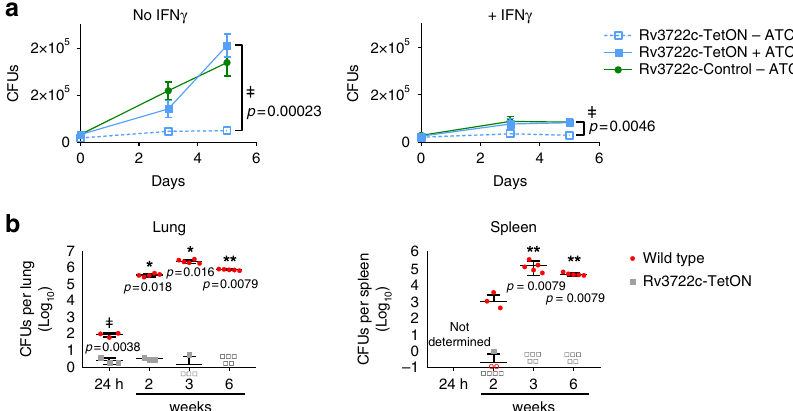
Fig. 2 Rv3722c is required for virulence in macrophages and mice. a Timecourse of macrophage infection. Primary murine bone marrow-derived macrophages were treated with control or interferon γ (IFN γ ) for activation, followed by infection with Rv3722c-control and Rv3722c-TetON precultured in 7H9 + casein hydrolysate with or without ATC to predeplete Rv3722c (multiplicity of infection of one). The number of colony-forming units (CFUs) was assessed by plating serial dilutions on 7H10 solid media supplemented with casein hydrolysate and ATC. Data are presented as mean + / − SD of three experimental replicates ( n = 3) representative of two independent experiments. b Timecourse of mouse infection. Mice were infected with aerosolized wild-type Mtb and Rv3722c-TetON precultured in Sauton ’ s without ATC to generate Rv3722c-de fi cient Mtb . After infection, mice were fed chow without doxycycline. The numbers of CFUs in lung and spleen were assessed by plating serial dilutions on 7H10 solid media with and without ATC to determine the number of non-ATC-dependent mutants. No non-ATC-dependent Rv3722c-TetON mutants were detected at any timepoint. Data are represented as mean + / − SD of fi ve mice ( n = 5), except for the 24 h timepoints ( n = 3) and Rv3722c-TetON 3 weeks in the lung ( n = 4). Open symbols indicate samples in which the bacterial burden was below the limit of detection (<2 CFUs). A similar experiment is shown in Supplementary Fig. 2. Source data are provided as a Source Data fi le. Statistically signi fi cant differences were identi fi ed in panel a by a combination of a two-sided unpaired Students t test ( p < 0.05, as indicated) and Mann – Whitney U rank testing (for which the smallest possible p -value with n = 3 is 0.1) (double dagger); and in panel b by an unpaired, two-sided Mann – Whitney U rank testing ( *p < 0.05, **p < 0.01, as indicated), except for the 24 h timepoint, in which statistically signi fi cant differences were determined as in a Rv3722c functions as an aspartate aminotransferase . To de fi ne studies identi fi ed Asp as the preferred substrate and Kyn as a the substrate speci fi city of Rv3722c, we next incubated Rv3722c weaker alternative (Fig. 3d), with af fi nities towards Asp that were with a panel of 26 amino acids, using α KG, pyruvate, and oxa- similar to AspATs from other species 21,22 . His, Cys, Asn, and Gln exhibited extremely low rates of turnover consistent with kinetic loacetate as potential amino acceptors. Oxaloacetate and α KG, side reactivity (Supplementary Fig. 4C). These results thus but not pyruvate, served as amino acceptors, while kynurenine annotate Rv3722c as an aspartate aminotransferase (AspAT; (Kyn), Asp, and Glu served as the best amino donors (Supple- Fig. 3e), with a weak, but signi fi cant, side activity toward Kyn, as mentary Fig. 4A). In contrast, His, Cys, Asn, and Gln exhibited observed in AspATs from other species 23 . minimal activity (Supplementary Fig. 4A, B). Formal kinetic